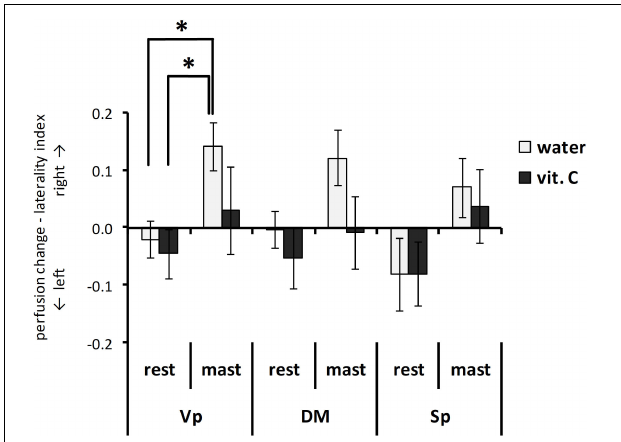
FIGURE 5 | Perfusion change—laterality index. Bars represent the laterality index LI (see text for definition) obtained from each trigeminal nucleus after a vit. C supplemented (vit. C) or control (water) lunch and resting (rest) or masticating (mast) for 1 h. There was a significant effect for the mastication factor from the Vp and the Sp nuclei ( P < 0.05). * t -test with Bonferroni correction for six multiple comparisons, p < 0.05.